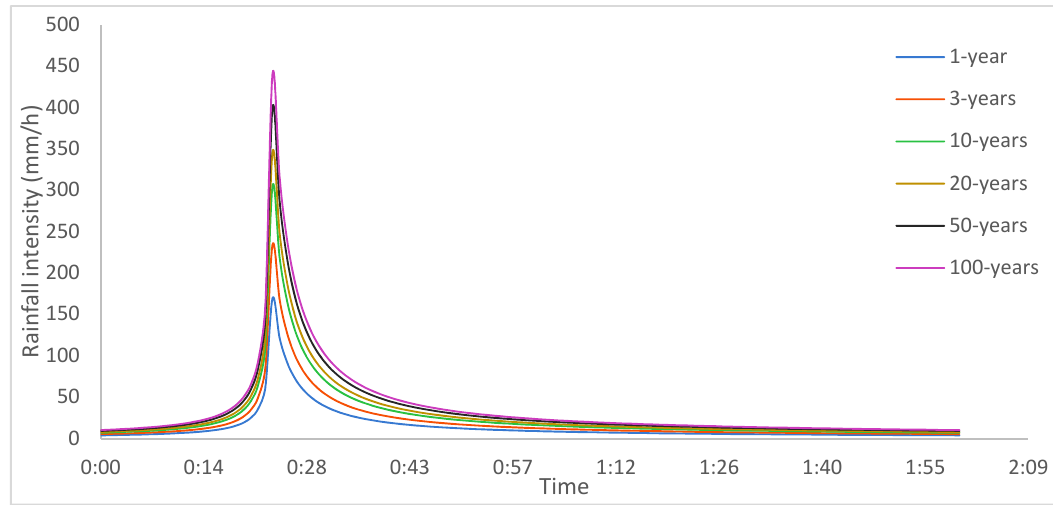
(Figure 4). On top of the baseline settings, the LID facilities were added into sub-catchments